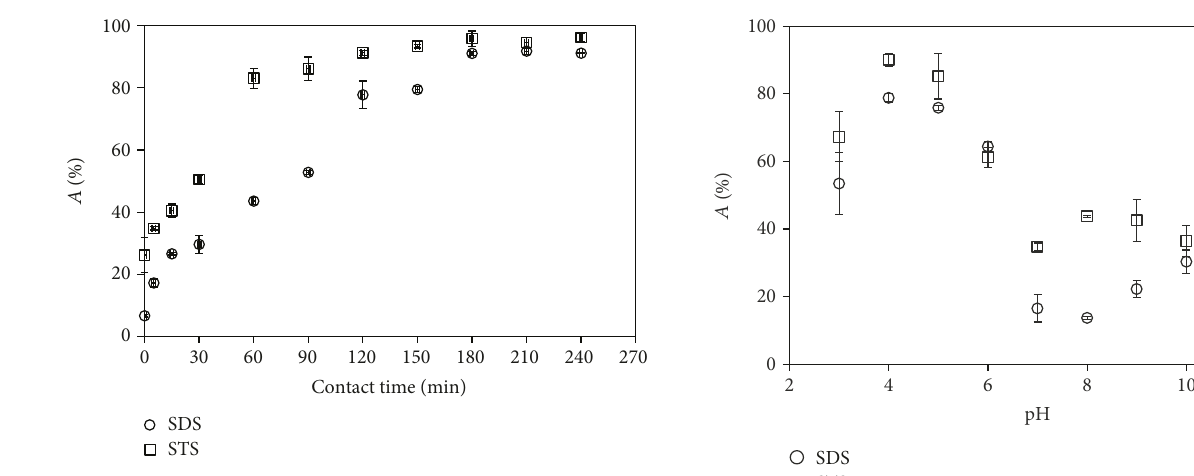
Figure 2: E ff ect of contact time on the adsorption e ffi ciency of SDS and STS onto Al O . Error bars show standard deviations of three 2 3 replicates.